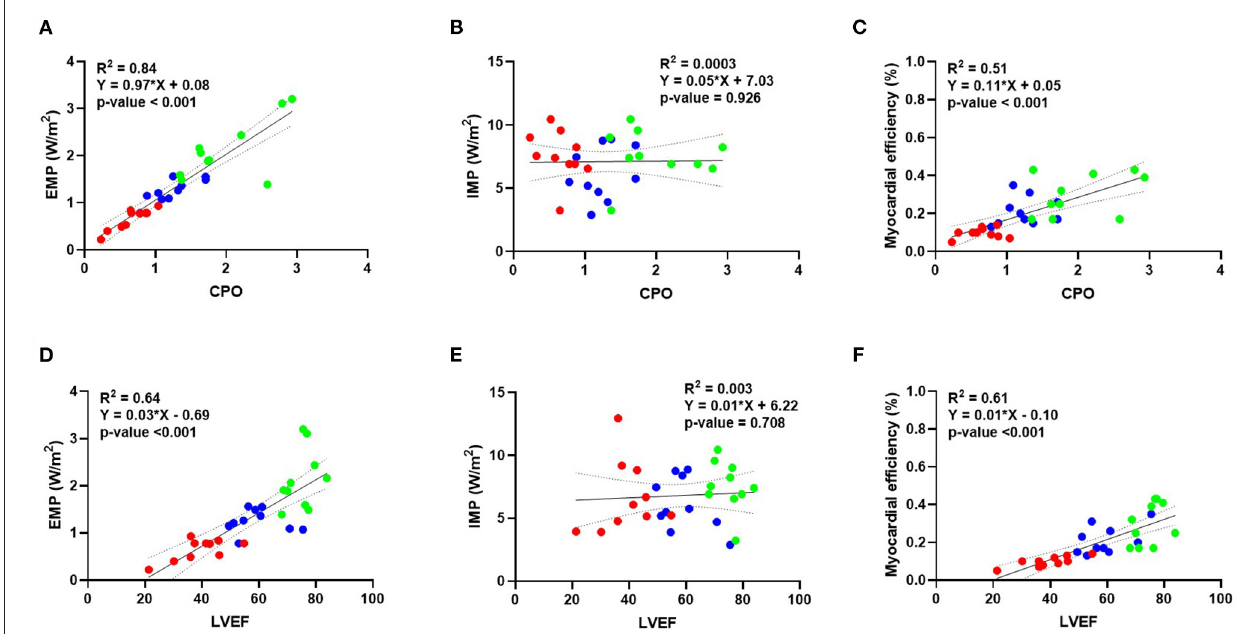
FIGURE 3 | Correlation between external myocardial power, internal myocardial power, and myocardial efficiency vs. different invasive parameters of hemodynamics. Linear regression analysis showing a good correlation between external myocardial power vs. CPO (A) and LVEF (D) . No correlation is instead observed for internal myocardial power and CPO (B) or LVEF (E) . A moderate correlation is observed for myocardial efficiency vs. CPO (C) and LVEF (F) . Blue dots represent baseline, green dots represent dobutamine, and red dots represent verapamil. BSA, body surface area; CPO, cardiac power output; LVEF, left ventricular ejection